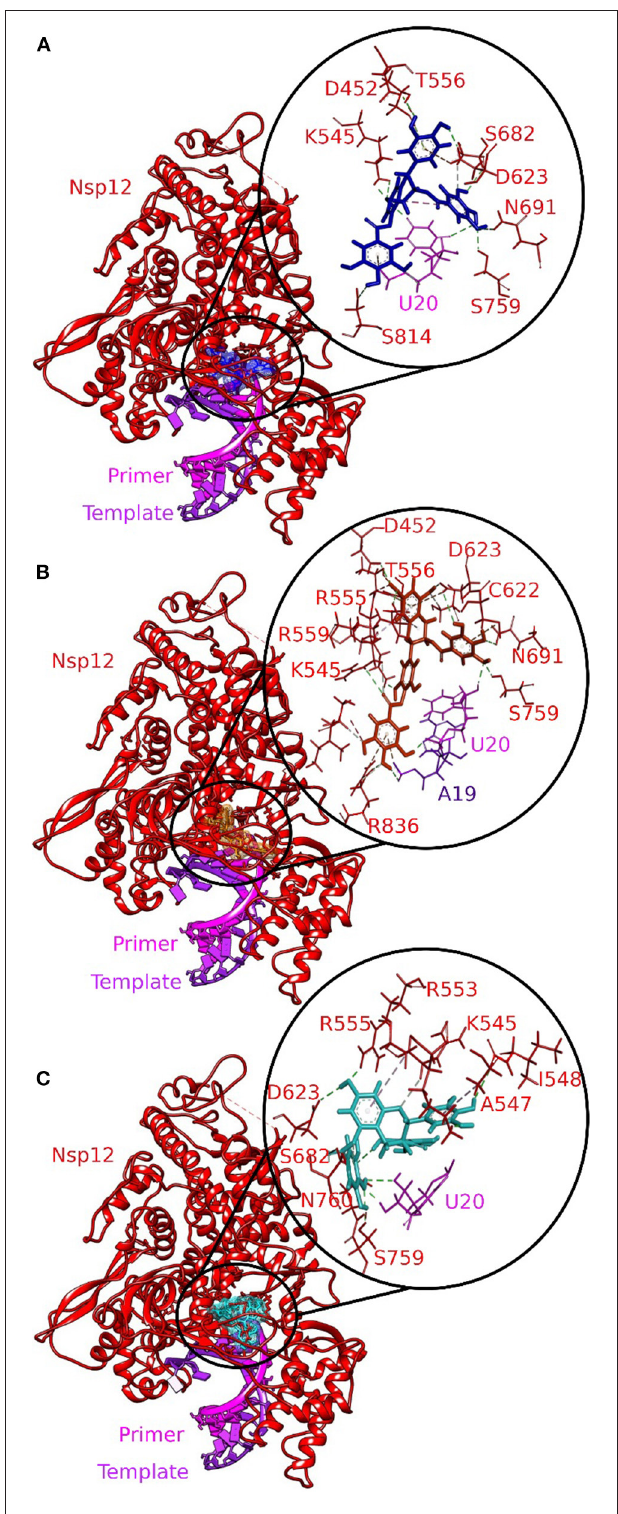
FIGURE 2 | Molecular docking interaction poses of bioactive molecules from tea with the active site of the RNA–RdRp complex of SARS-CoV-2. (A) Epicatechin-3,5-di-O-gallate, (B) epigallocatechin-3,5-di-O-gallate, and